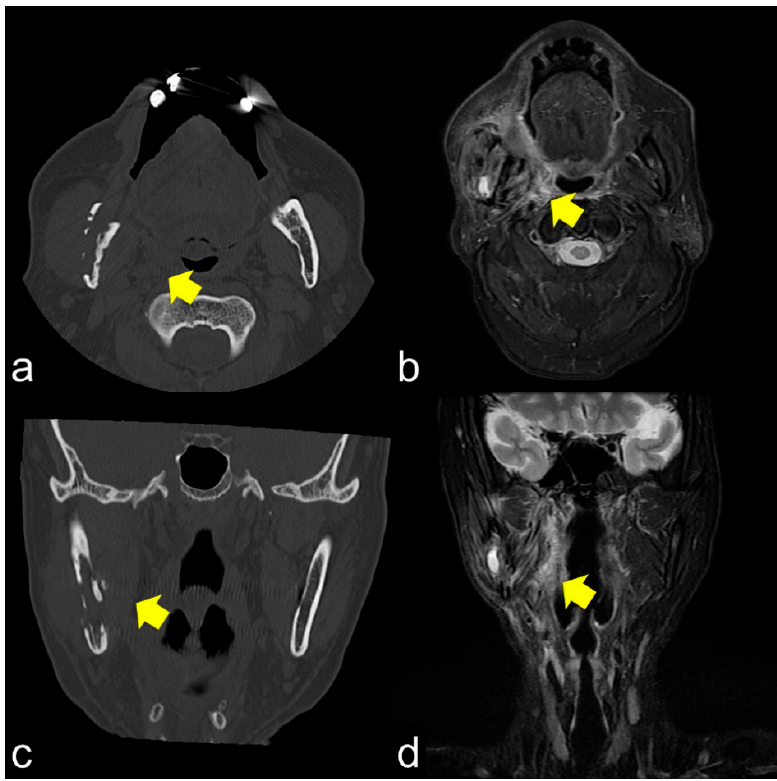
Figure 3. ( a , b ) Axial CT and T2 WI magnetic resonance images show cortical bone disruption and abnormal signal intensity in the masticatory muscle; ( c , d ) Coronal images also show chronic inflammation, particularly in the medial pterygoid muscle. Chronic inflammation in the masticatory muscles results in trismus.